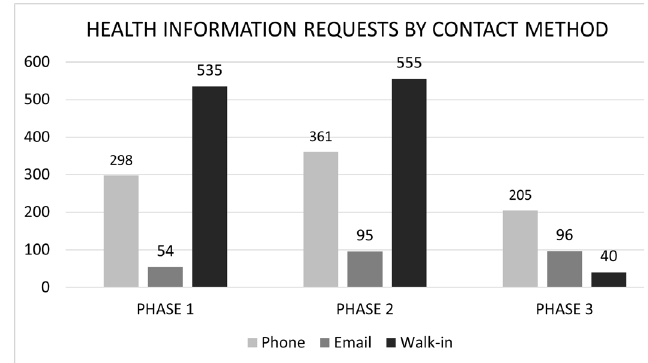
Figure 2 Health Information Requests by Contact